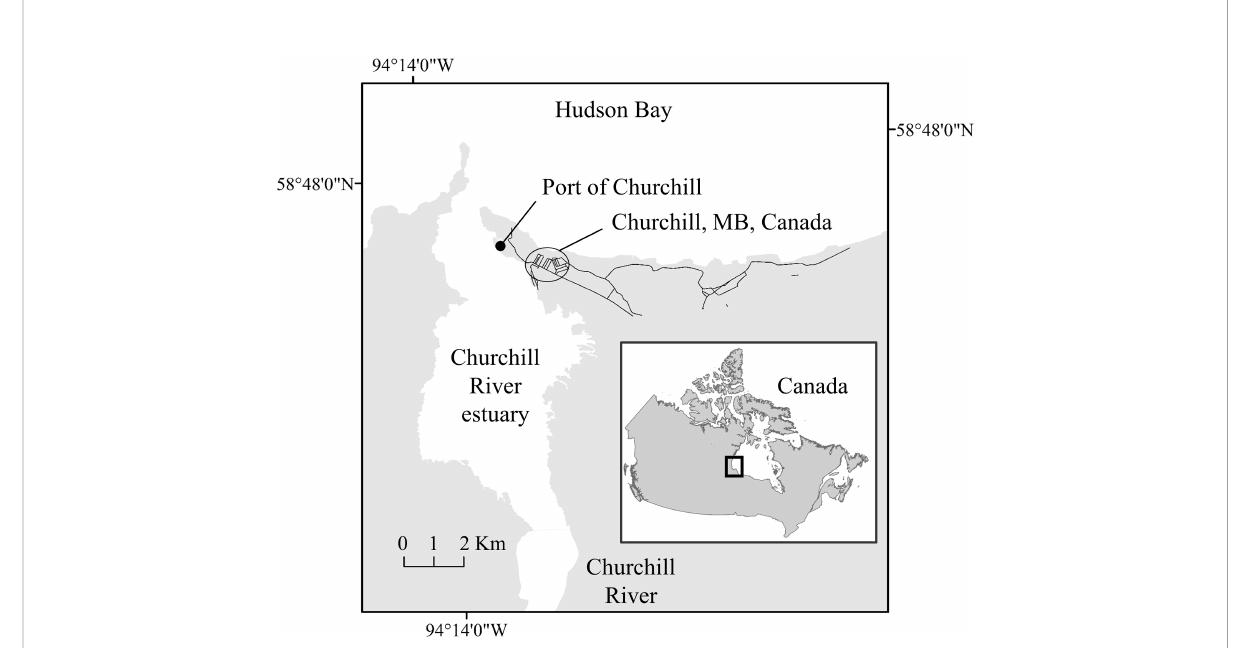
FIGURE 1 Map of the Churchill River estuary with the Port of Churchill located in Hudson Ba, Manitoba,